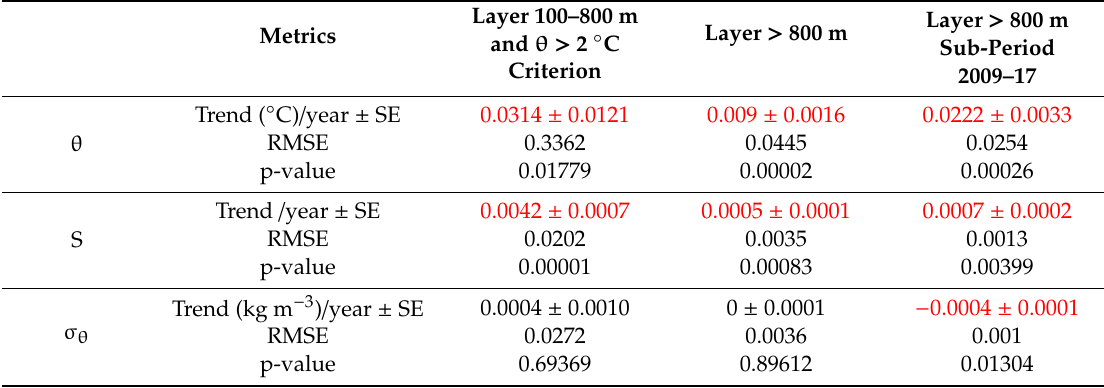
Table 1. Linear trends of θ , S and σ θ in the intermediate (100–800 m) and deep ( > 800 m) layers from CTD casts collected along section S (see Figure 1 and Figure 3). Data cover the period from 1997 until 2017. Significant linear trends (p < 0.05) are reported in